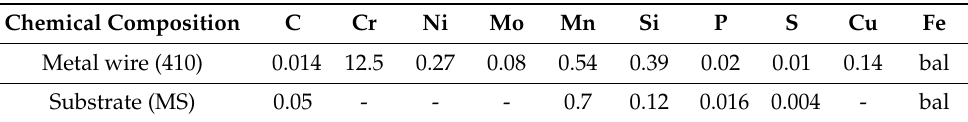
Table 1. The chemical composition of the SS410 feedstock wire and the substrate used in the WAAM process for bulk fabrication.